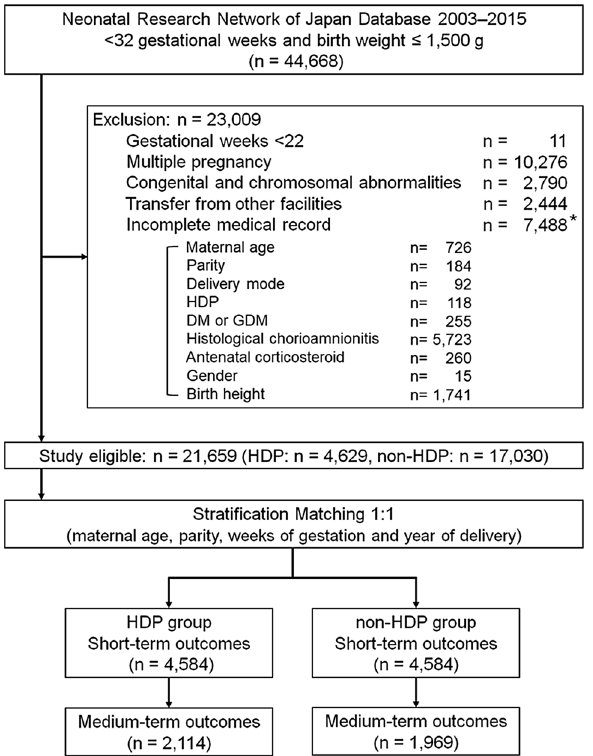
Figure 1. Study enrolment. Data on 44,668 neonates born at NICUs participating in the Neonatal Research Network of Japan from January 2003 to December 2015 were available. Each of 4,584 neonates in the HDP and non-HDP groups was selected from eligible infants (HDP, n = 4,629; non-HDP, n = 17,030) after stratification matching using four factors, including maternal age, parity, weeks of gestation, and year of delivery. *Items not mutually exclusive. GDM, gestational diabetes mellitus; DM, diabetes mellitus; HDP, hypertensive disorders of